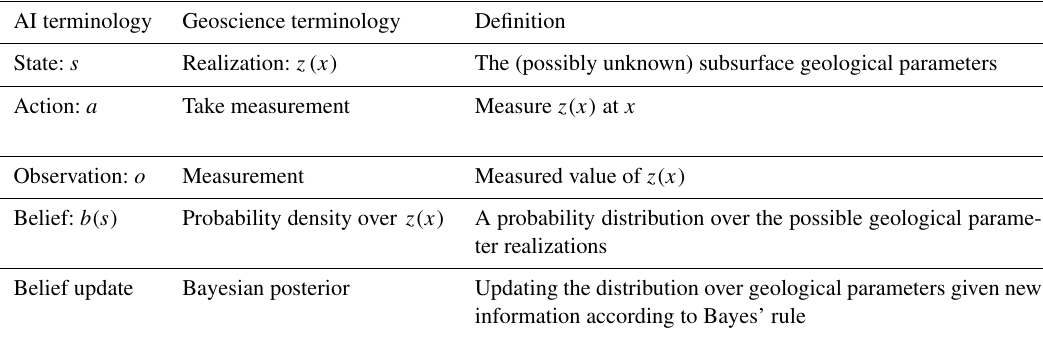
Table 1. Comparison between AI and geostatistical